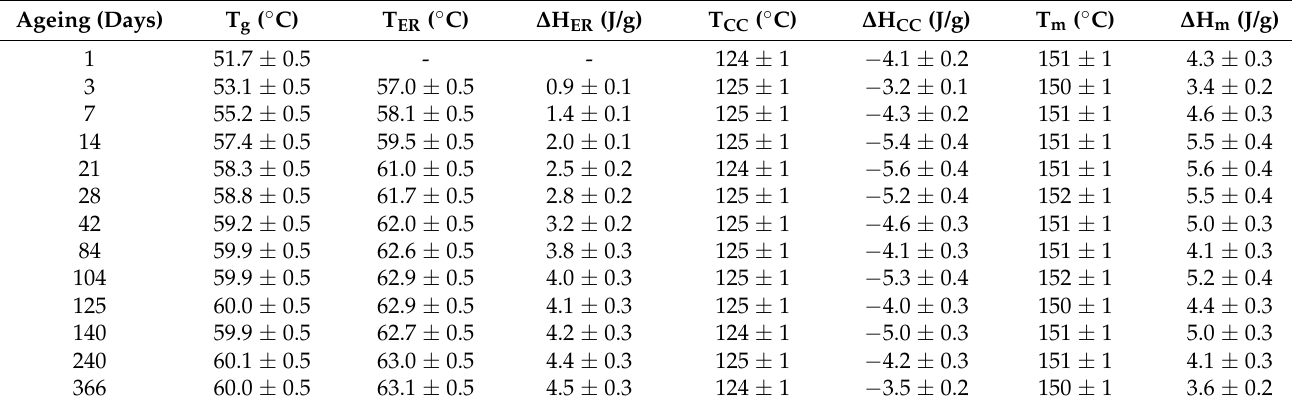
Table 1. Thermal properties of the extruded 1D PLA. All samples were extruded at 190 ◦ C. T g : glass transition; T ER : enthalpic relaxation temperature; ∆ H ER : enthalpy of enthalpic relaxation; T CC : cold crystallisation temperature; ∆ H CC : enthalpy of cold crystallisation; T m : melting temperature; ∆ H m : enthalpy of melting. Following IUPAC’s convention, positive enthalpy changes indicate that the material absorbs the energy, which is indicative of an endothermal reaction. Ageing